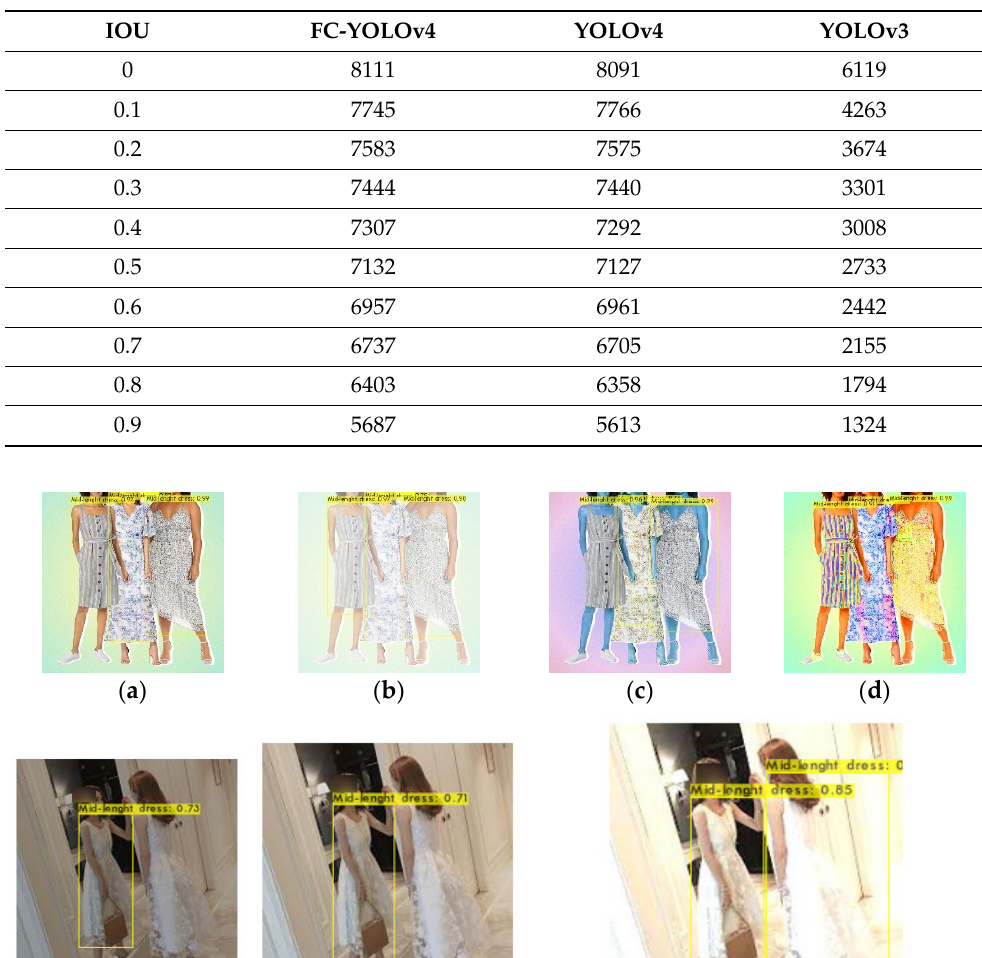
Table 8. The number of true positive results with different thresholds.